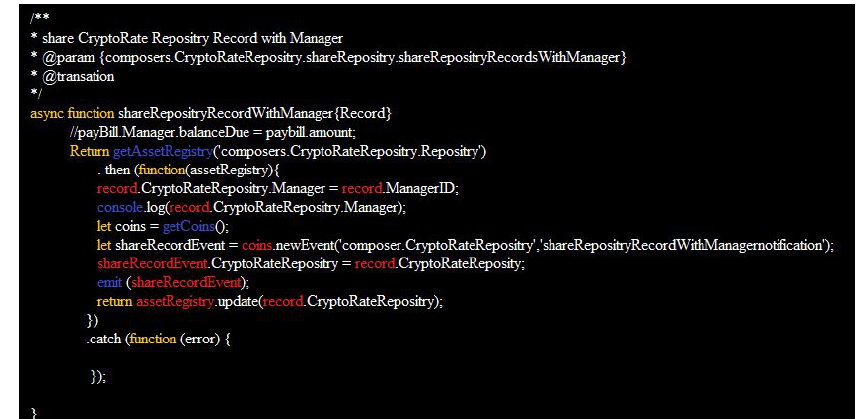
Figure 4. Transaction process function based on the blockchain framework.